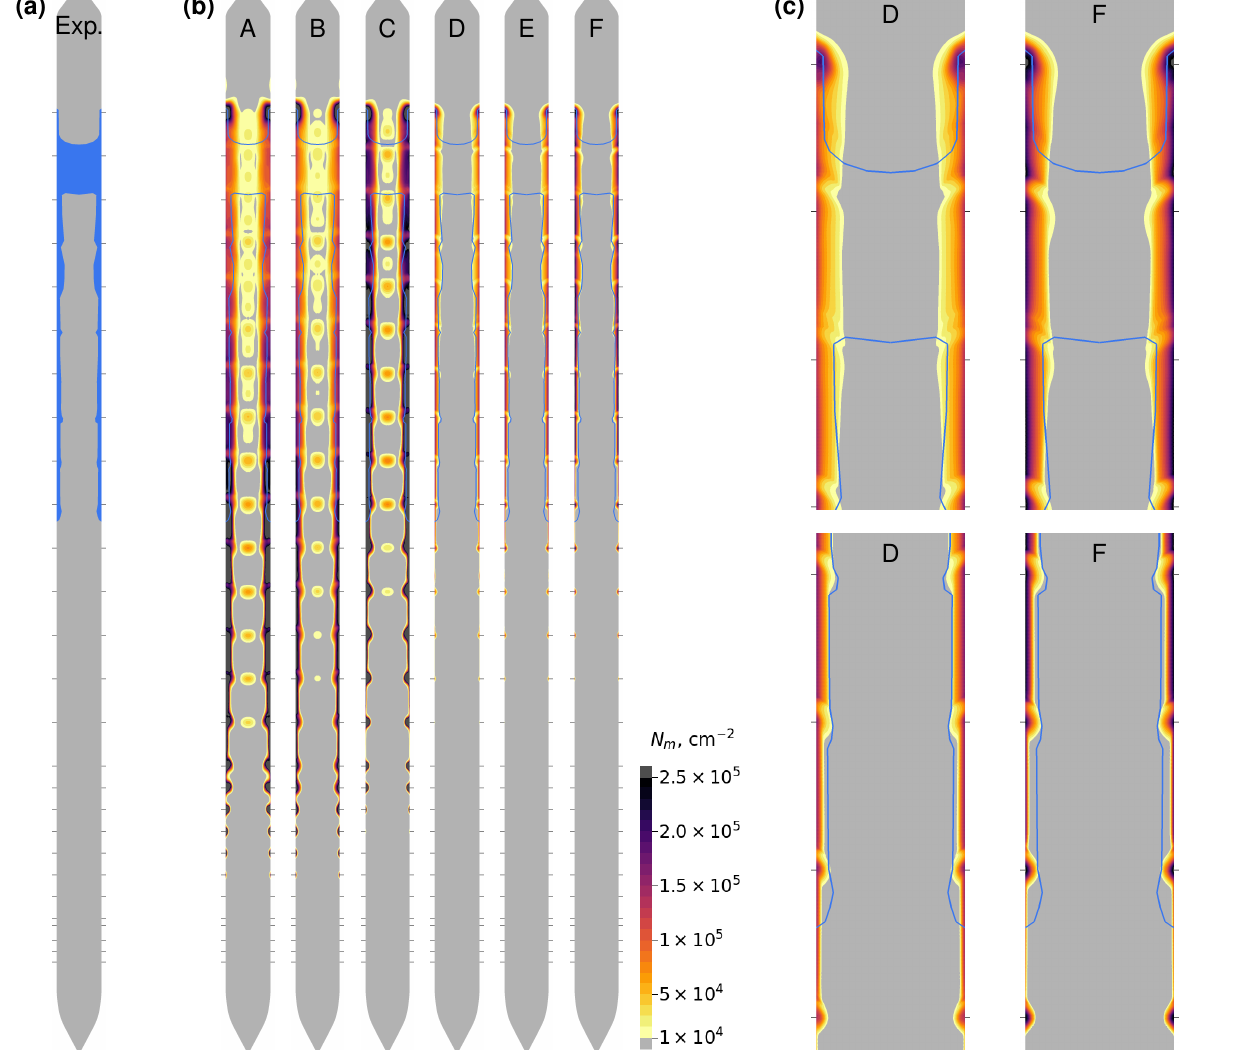
Figure 7. ( a ) Shape of dislocated zone in experiment; ( b ) calculated dislocation density in the whole crystal according to cases A–F in Table 1; ( c ) zoomed-in simulation results at two positions for cases D and F. Experimentally observed boundary of the dislocated zone is depicted in ( b , c ) as blue curves. Black horizontal lines show heating positions at which the crystal is not